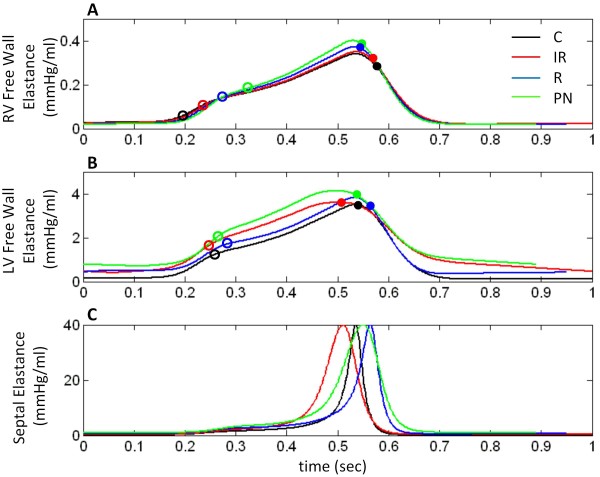
Ventricular Free Wall and Septal Elastance. Plots of RV free wall (Panel A), LV free wall (Panel B), and septal (Panel C) elastance. Open circles indicate outlet (pulmonic and aortic) valve opening, closed circles indicate outlet valve closure. Septal elastance bears a sharp peak coincident with RVF and LVF maximum elastance in control (black line). With IR-type (red line), LVF and septal elastance depict abnormal relaxation, and the peaks widen. With R-type (blue line), septal elastance peak is delayed, occurring after free wall elastance peaks, delaying aortic valve closure. With PN-type (green line), plots show signs of both effects with abnormal LVF and septal elastance downstroke, and delayed and widened septal elastance peak. In all LVDD cases, pulmonic valve opening is delayed. See text for details.